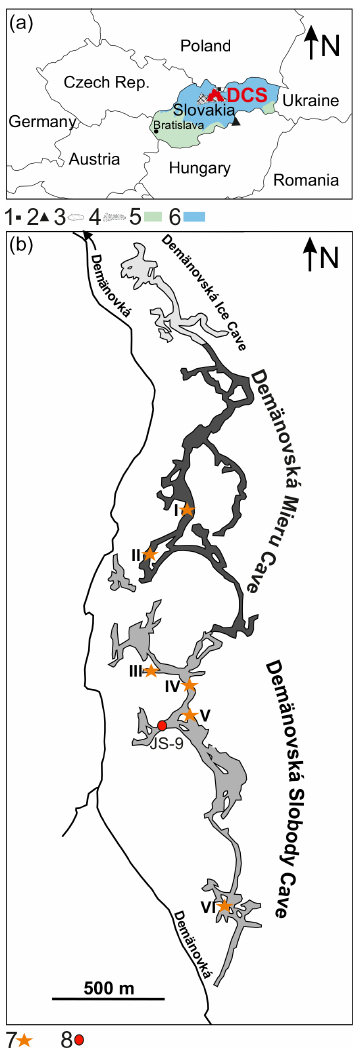
Figure 1. (a) The location of the Demänová Cave system. (b) A map of the Demänová Cave system. The numbers used in the panel legends refer to the following: 1 – the Magurska Cave site, 2 – the Baradla Cave site, 3 – the Tatra Mountains, 4 – the Low Tatras, 5 – the Cfb climate zone, 6 – the Dfb climate zone, 7 – the sites with cave temperature monitoring and 8 – the sample collection